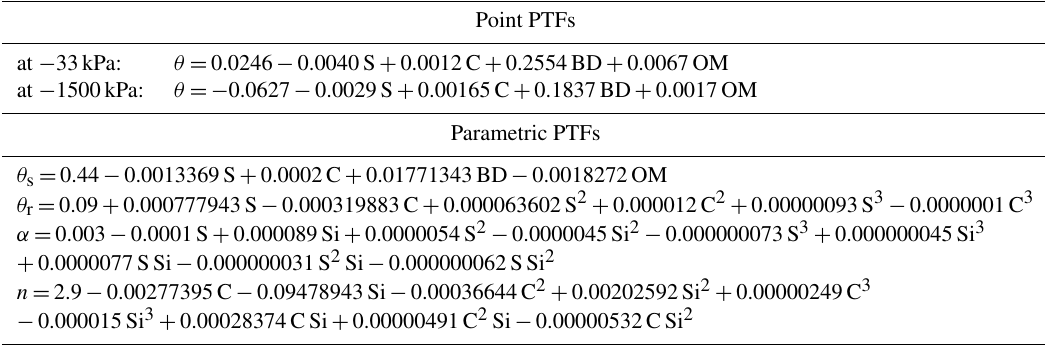
Table 2. Developed pedotransfer functions